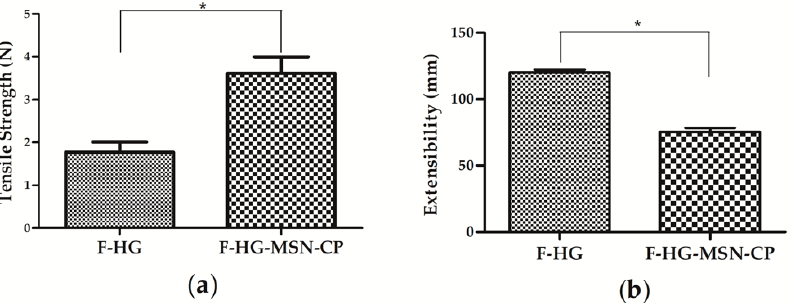
Figure 8. Tensile strength ( a ) and extensibility ( b ) of 3D-printed films: F-HG and F-HG-MSN-CP ( n = 3, mean ± SD). Student’s t-test was used to compare the samples. * p ≤ 0.05.